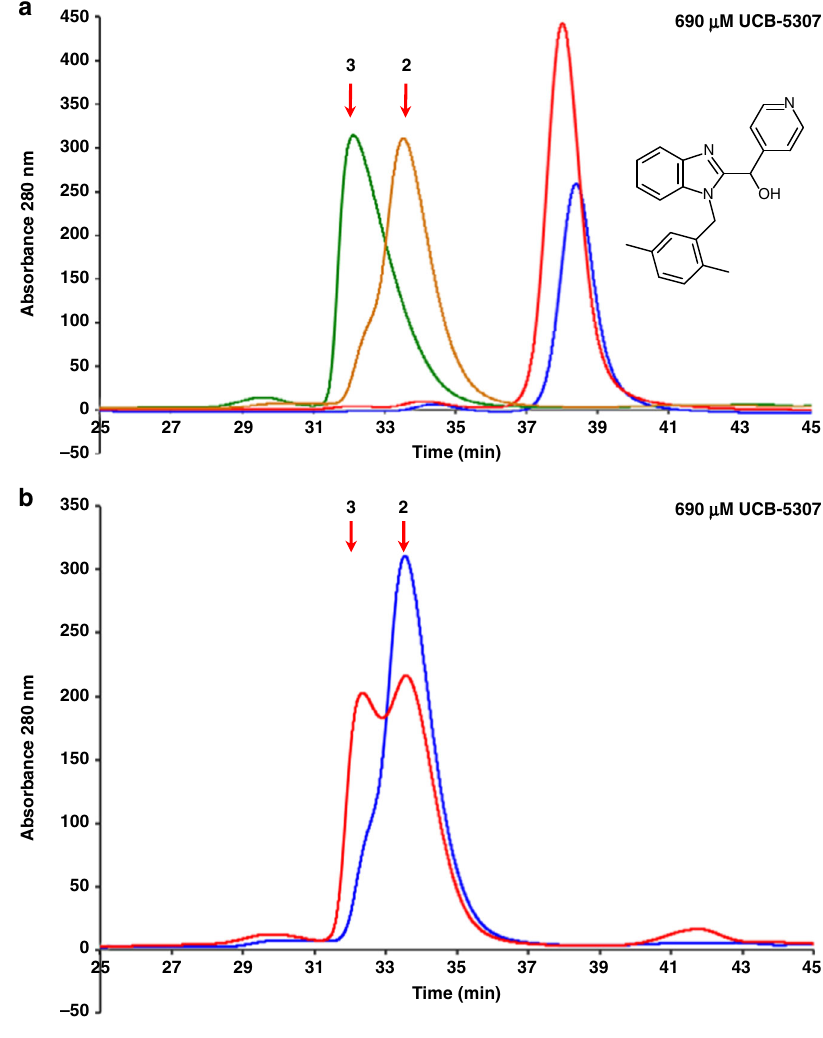
Fig. 4 Effect of compounds on TNF:TNFR1 stoichiometry. a Analytical size exclusion chromatography (AnSEC) of human (h) TNF alone (blue trace), hTNF + UCB- 5307 (red trace), hTNF + 3.2-fold excess hTNFR1 (green trace) and hTNF + 3.2-fold excess hTNFR1 + 690 µ M UCB- 5307 (brown trace). Expected migration position of hTNF with two and three receptors bound are indicated by arrows. Standard trace shown in Supplementary Fig. 5. b AnSEC comparing effect of 690 µ M UCB- 5307 on preformed hTNF/hTNFR1 complex (3.2-fold excess hTNFR1) (red trace) vs. hTNF preloaded with UCB- 5307 followed by addition of 3.2-fold excess hTNFR1 (blue trace) as in experiment ( a ). Source data are provided as a Source Data fi